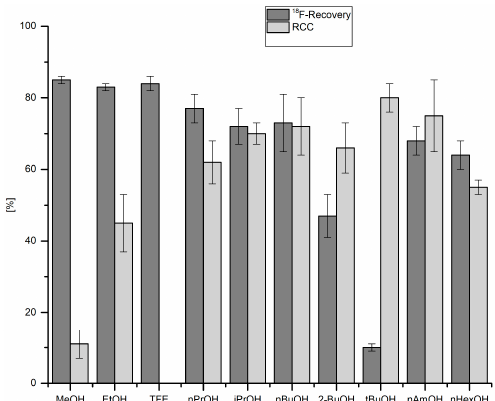
Figure 2. Effect of alcohol on 18 F-recovery and 18 F-incorporation. Conditions: 18 F − (50–150 MBq) was eluted from a QMA-CO 3 cartridge into the reaction vial with a solution of Et 4 NOTf (3.1 mg, 11 µ mol) in the corresponding anhydrous alcohol (300 µ L) (see legend of Table 1); to this solution a solution of trimethyl(phenyl)tin (14.5 mg, 60 µ mol) and Cu(py) 4 (OTf) 2 (20.3 mg, 30 µ mol) in DMA (700 µ L) was added,